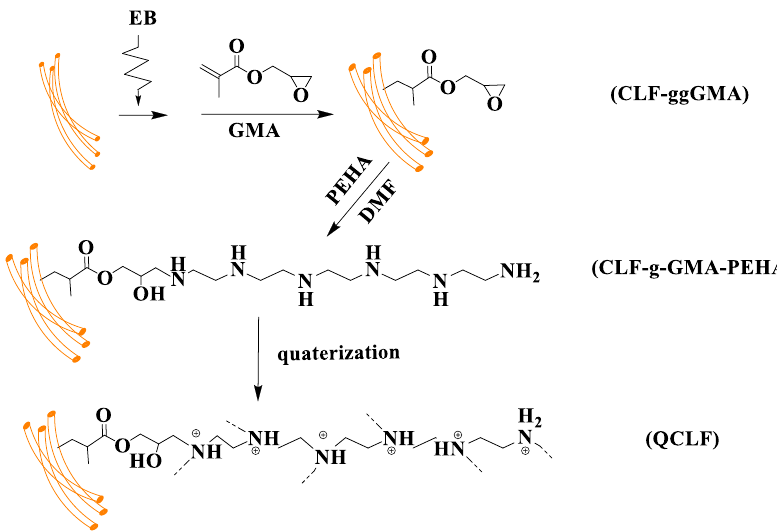
Figure 1. Synthesis route of quaternized cotton linter fiber (QCLF) adsorbent.